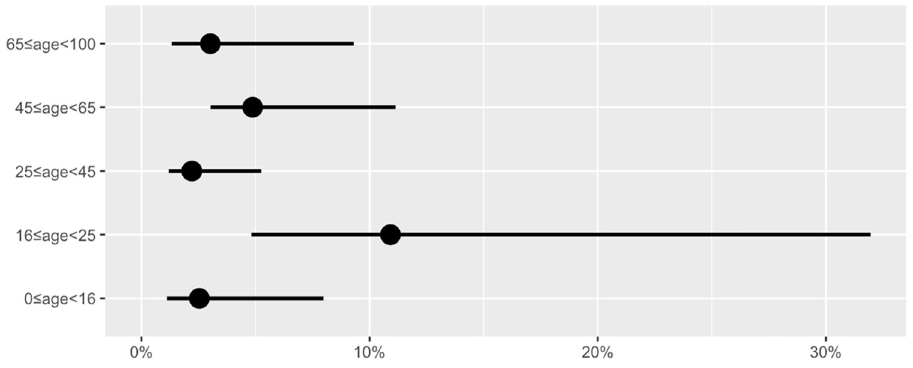
Fig 5. Estimated anti-SARS-CoV-2 seroprevalence across age group in King County in early-to-mid-August 2020. Age in years. Points indicate estimates and lines indicate 95% confidence intervals.